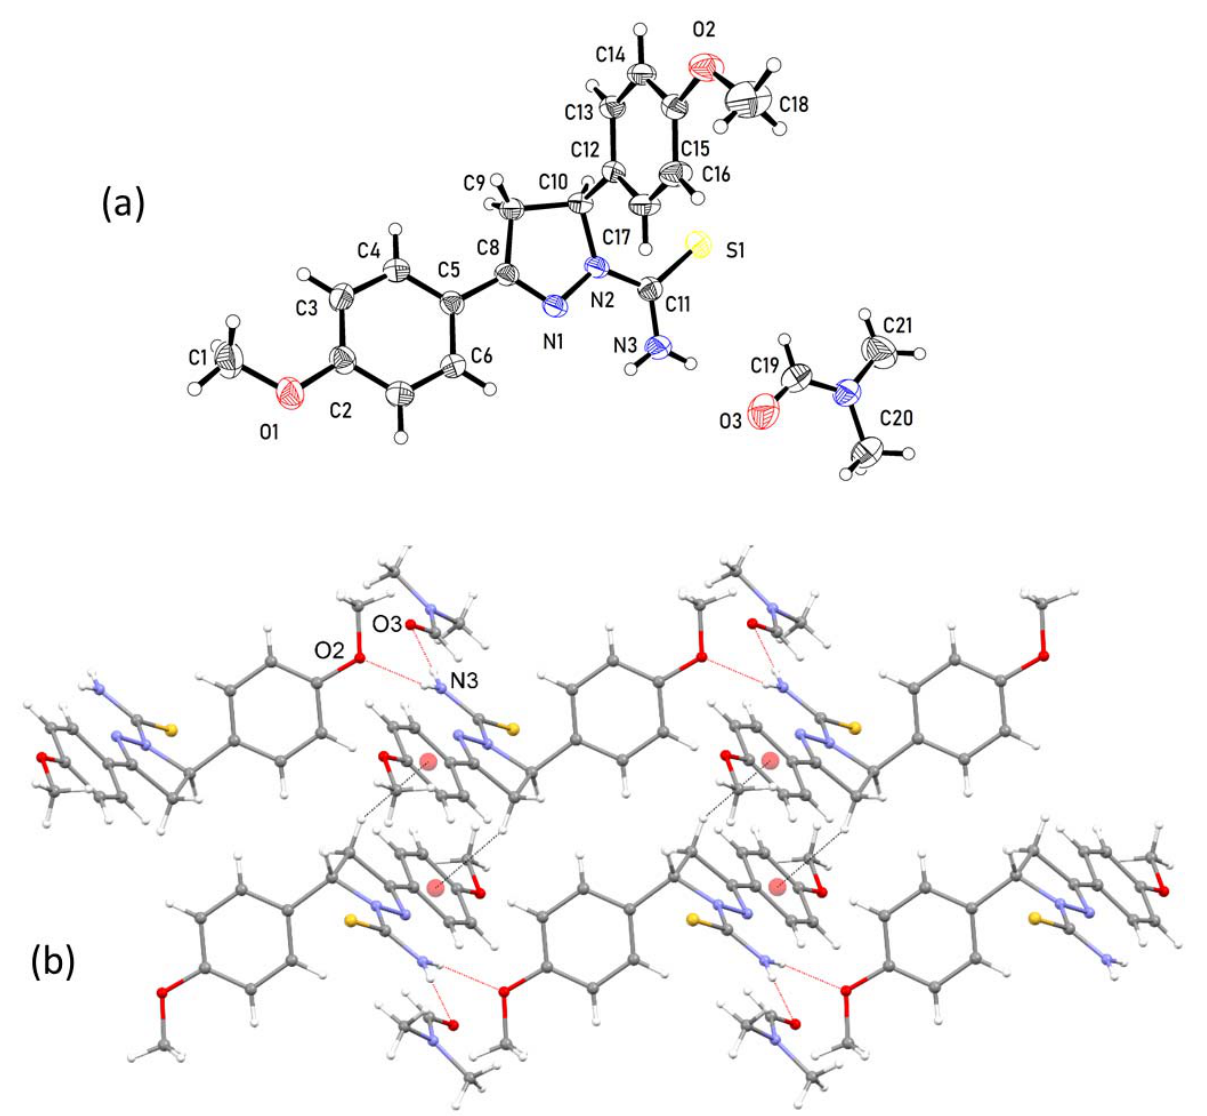
Figure 3. ( a ): The asymmetric unit of the 1 –DMF solvate showing the main component of the disordered DMF solvent with anisotropic displacement ellipsoids drawn at 50% probability level and ( b ): a segment of the structure of 1 –DMF showing intermolecular contacts.